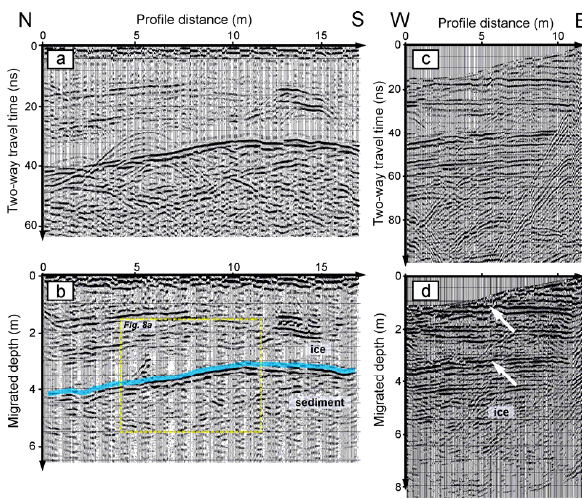
Figure 3: Radargram sections of the ice at "Feenpalast 1" (Fig. 2a) and "Feenpalast 2" (Fig. 2g) (Dachstein-Mammuthöhle). (a, b) The fairly diaphanous ice clearly exhibits the transition from ice to the fine-grained sediment. The blue line in the migrated section (b) shows the base. (c, d) Radargram sections of the intransparent ice with strata found close to the previous location. Arrows indicate the layers which are also seen on the side of the ice cliff (Fig. 2g)